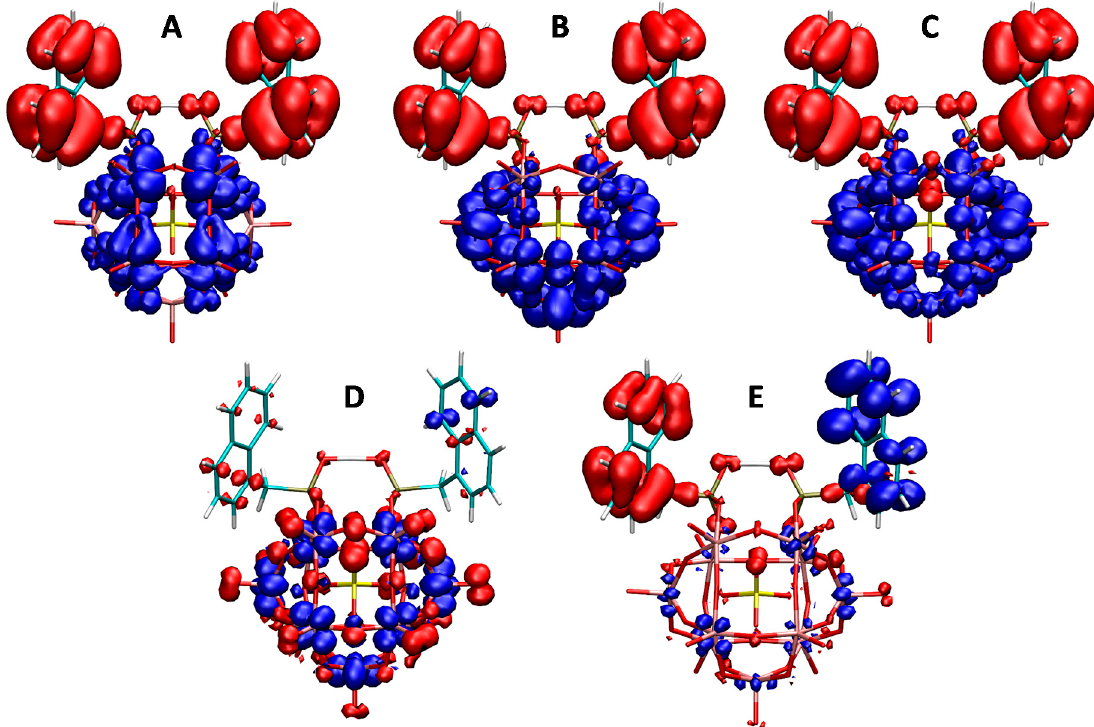
Figure 6. Difference densities for several CT transitions calculated for the hybrid POM 2 at the TDA-B3LYP/def2-SVP//BP86-D3/def2-SVP level of theory. The electronic transfer is from the red to the blue surfaces: ( A ) 408 nm; ( B ) 380 nm; ( C ) 350 nm; ( D ) 290 nm and ( E ) 290 nm.